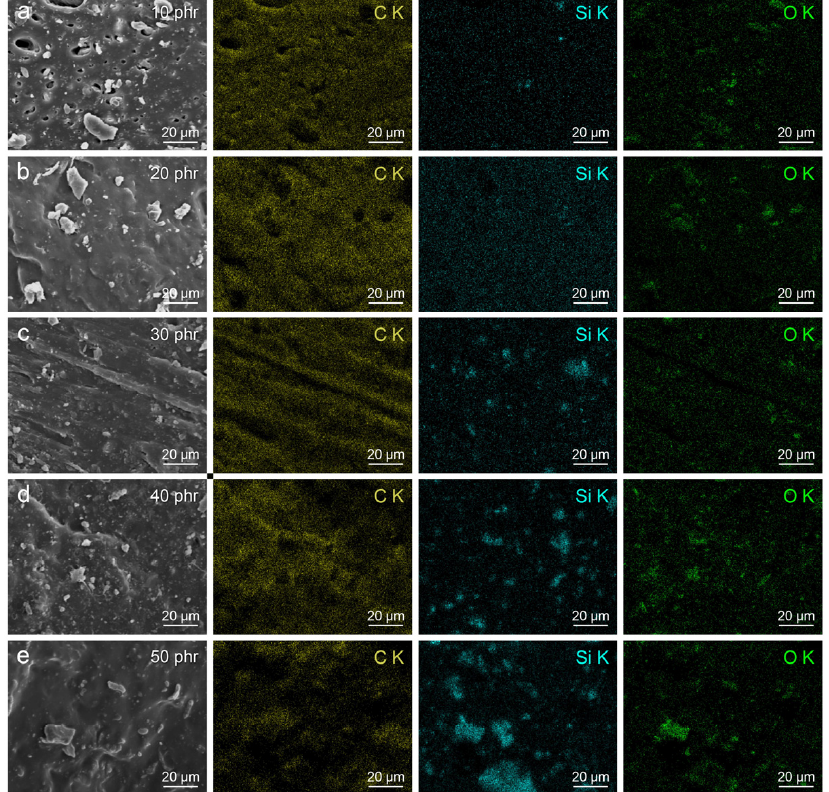
Figure 8. SEM-EDS mapping analysis of the NR composites filled with various Si69-RHS loadings: carbon (C K signal), silicon (Si K signal), and oxygen (O K signal) elements, respectively.